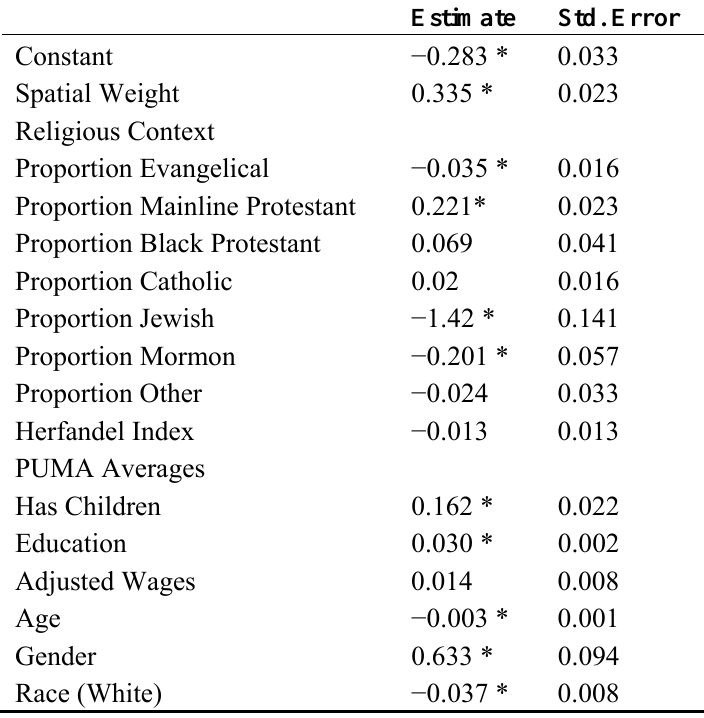
Table 2. Spatial regression of proportion married women